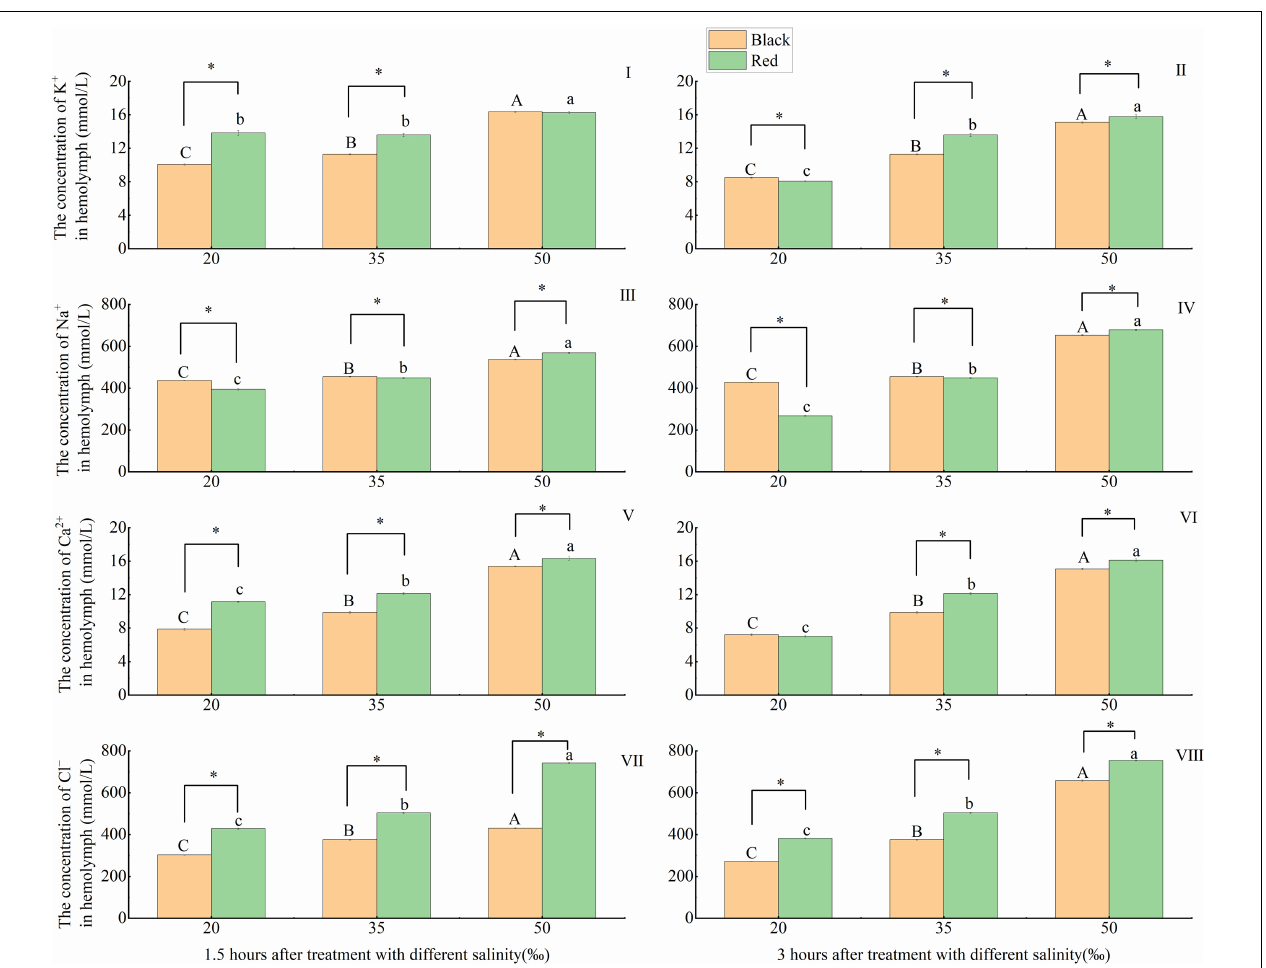
FIGURE 2 | Effects of acute salinity stress on the concentration of inorganic ions in the hemolymph of black and red P. fucata ( I : 1.5 h, K + concentration. II : 3 h, K + concentration. III: 1.5 h, Na + concentration. IV: 3 h, Na + concentration. V: 1.5 h, Ca2 + concentration. VI: 3 h, Ca2 + concentration. VII: 1.5 h, Cl − concentration. VIII: 3 h, Cl − concentration). The asterisk sign “ ∗ ” indicates that there are significant differences between the different shell colors at the same salinity ( p < 0.05).